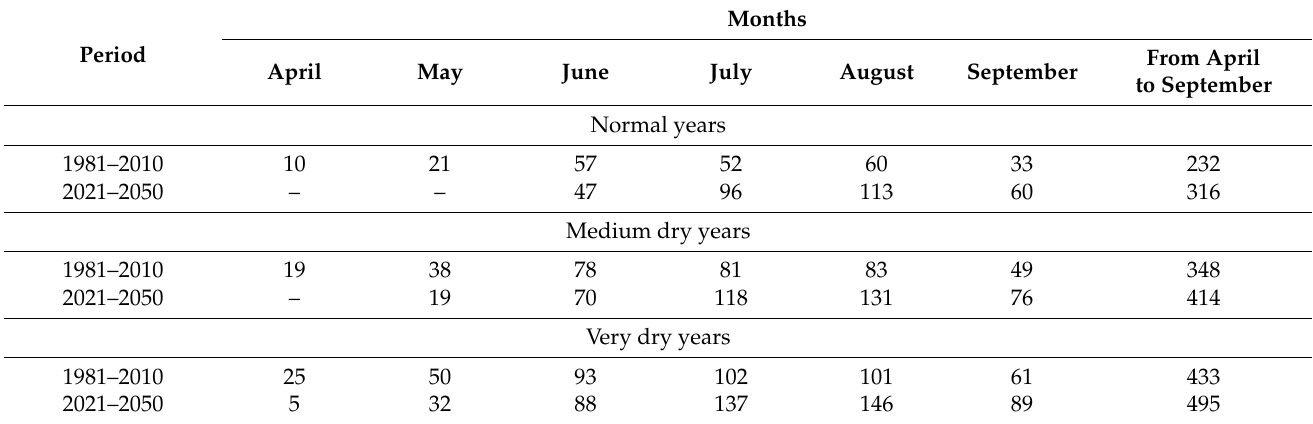
Table 5. Precipitation deficit (mm) for sweet cherry trees in normal, medium dry, and very dry years for the years 1981–2010 and